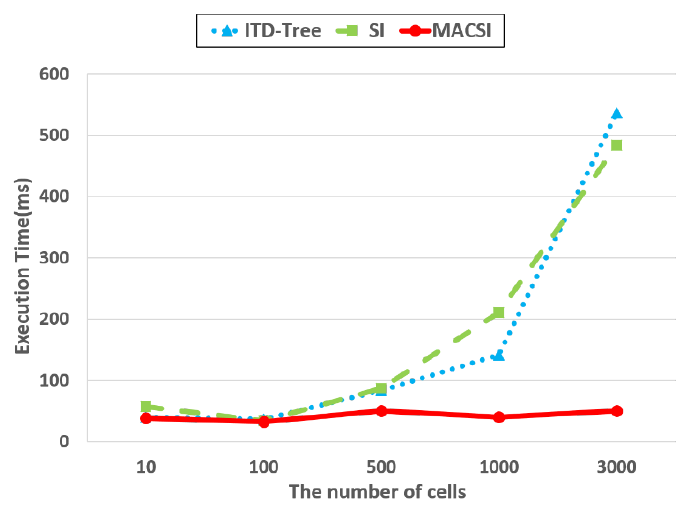
Figure 28. The effect of cell number on the update performance.